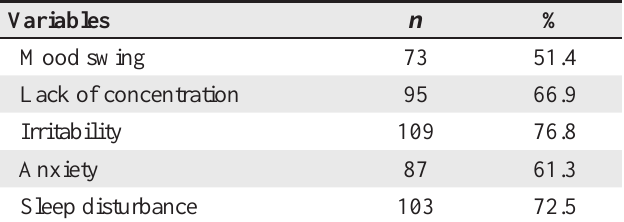
Table 4 : Respondents' knowledge on psychological sign and symptoms of perimenopause Variables